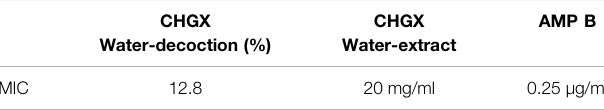
TABLE 1 | Antifungal susceptibility testing of CHGX formula against C. albicans